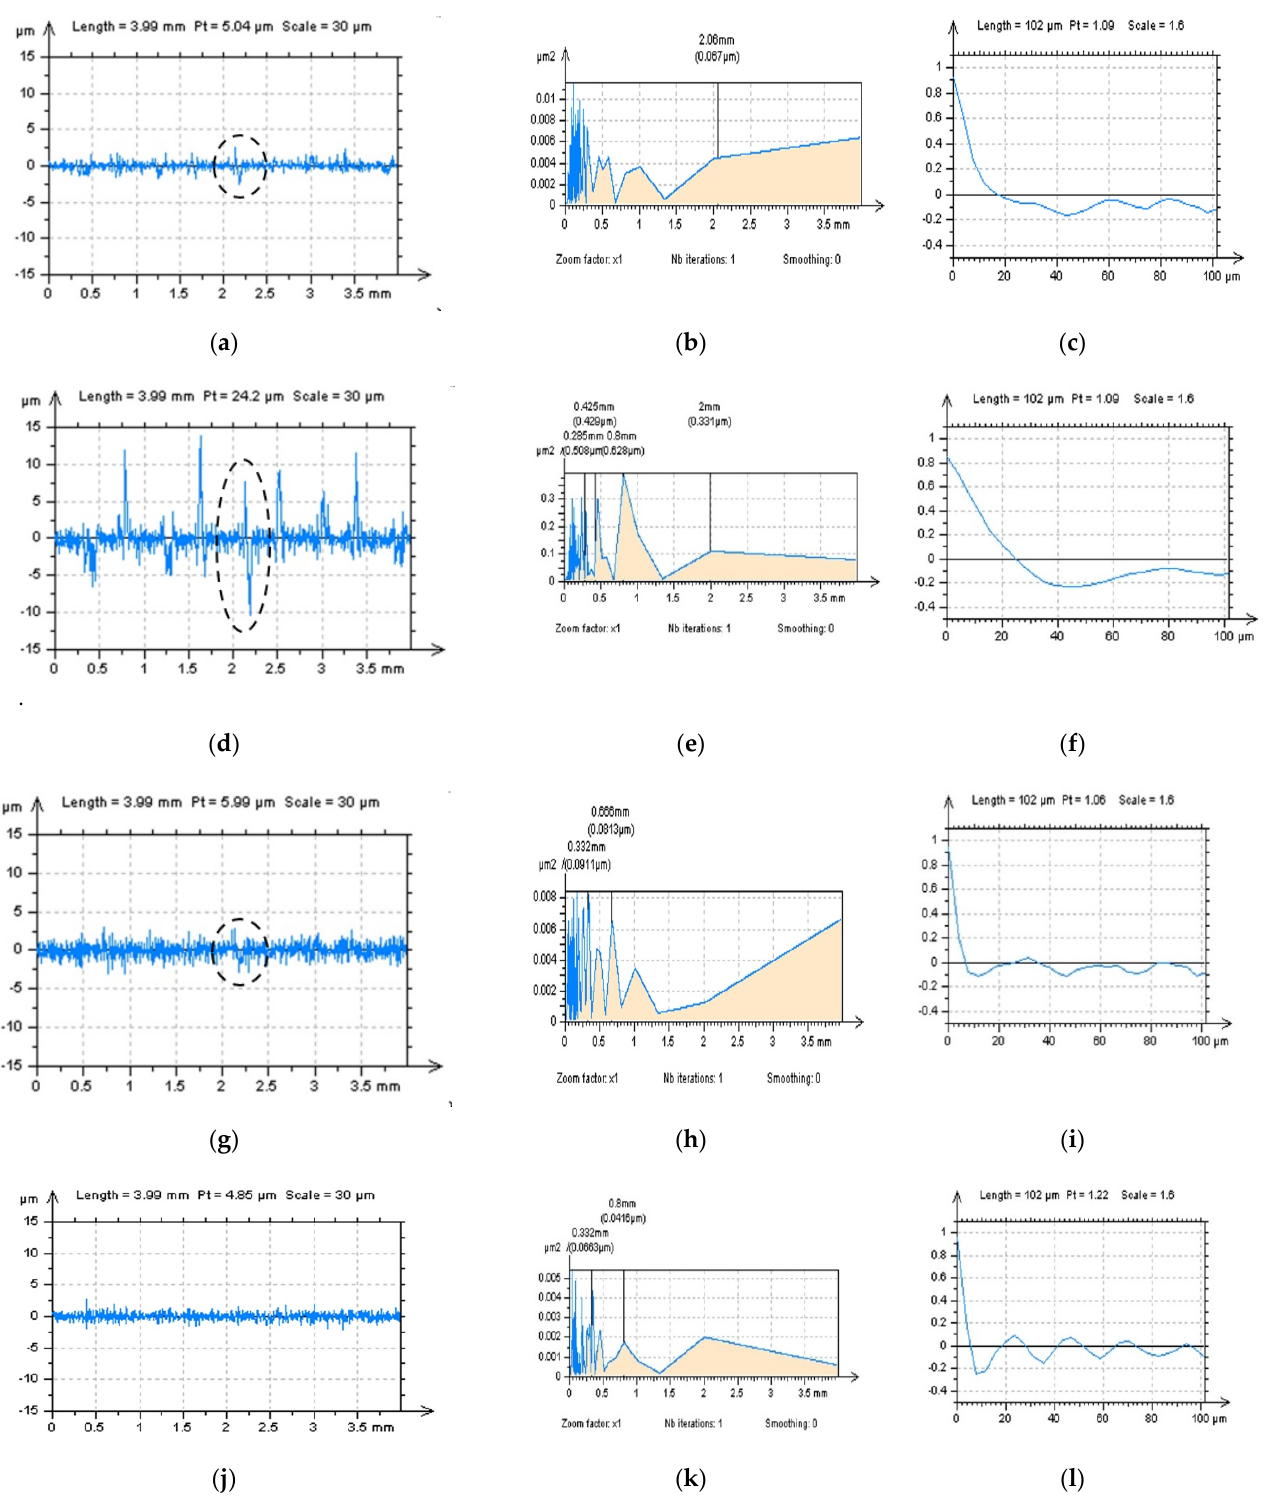
Figure 7. Profiles ( left column), their PSDs ( middle ) and ACFs ( right column) received from the NS created by application of GF ( a – c ), RGF ( d – f ), SF ( g – i ) and FFTF ( j – l ) method, cutoff = 0.025 mm.